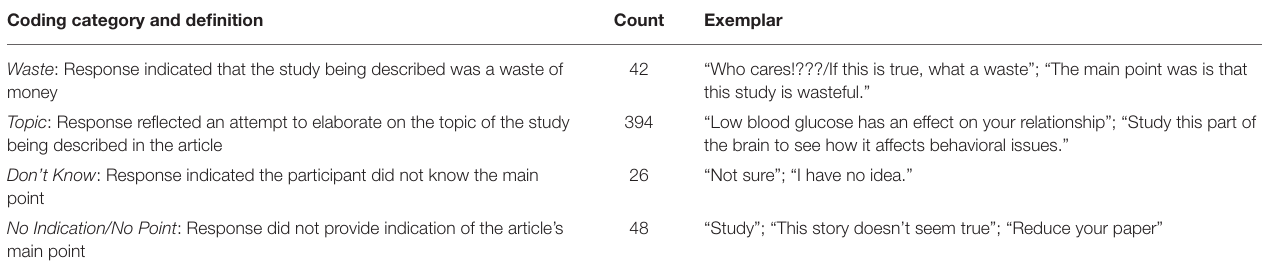
TABLE 1 | Coding categories and examples. Coding category and definition